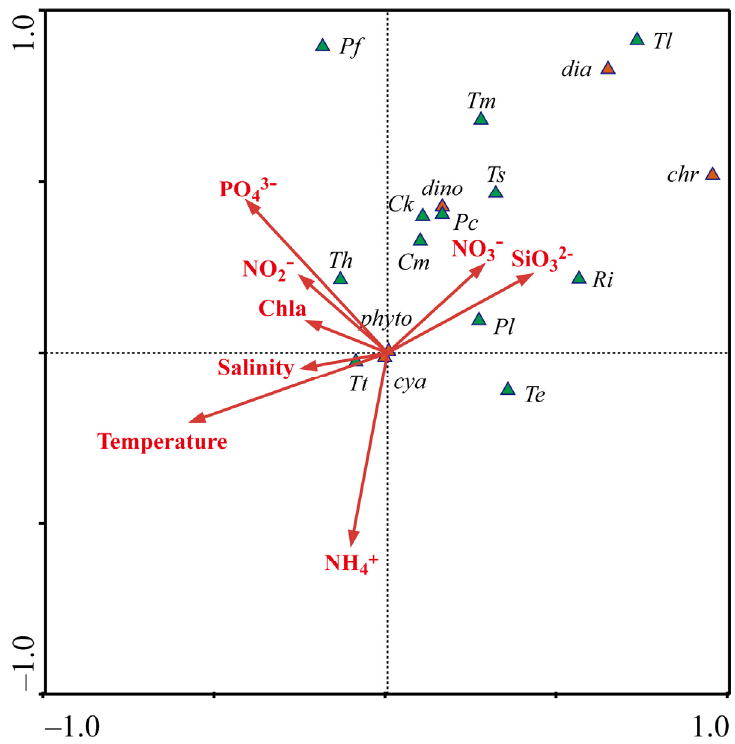
Figure 7. Canonical Correlation Analysis of the dominant phytoplankton species and environmental factors in the surface layer in the WPO during autumn, 2017. dia: diatoms; dino: dinoflagellates; cya: cyanobacteria; chr: chrysophyceae; Tt: Trichodesmium thiebautii ; Te: Trichodesmium erythraeum ; Th: Trichodesmium hildebrandtii ; Ck: Ceratium kofoidii ; Pl: Prorocentrum leniculatum ; Ri: Richelia intracellularis ; Pf: Planktoniella foromsa ; Cm: Coscinodiscus marginato-lineatus ; Ts: Thalassiosira subtilis ; Pc: Prorocentrum compressum ; Tl: Thalassiothrix longissima ; Tm: Thalassiosira minima